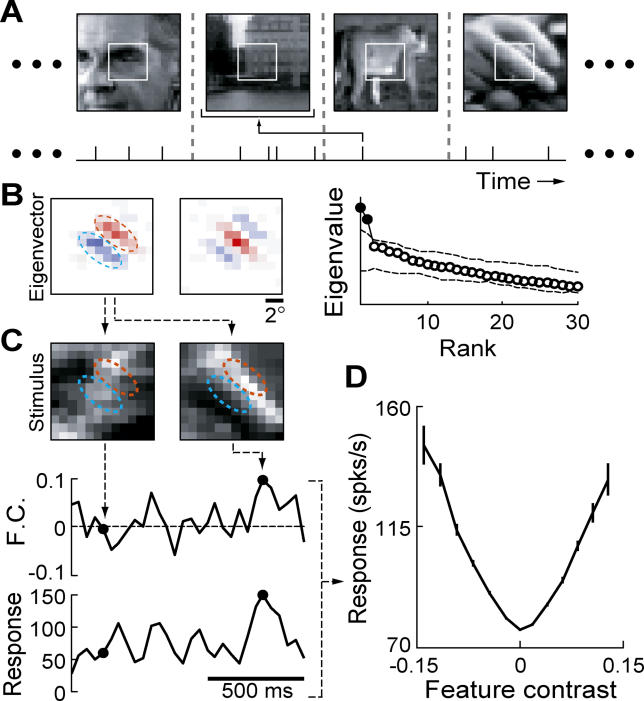
Measurement of Preferred Features and Feature Sensitivity for V1 Complex Cells(A) Upper panel: example natural images. White boxes (12 × 12 pixels) indicate area presented in experiments. Lower panel: schematic spike train, binned at stimulus frame rate (24 Hz, dotted lines). Arrow indicates temporal delay (1 frame) at which preferred features were estimated, which was determined in preliminary studies to be the optimal temporal delay (see Figure S2).(B) Estimation of preferred features (significant eigenvectors) using STC analysis (see Materials and Methods). Left panel: preferred features of a neuron, with light and dark regions represented by red and blue; dashed ovals delineate the first feature to facilitate comparison with the images. Right panel: 30 largest eigenvalues of STC matrix. Dashed lines: control confidence intervals (mean ± 12 standard deviation of control eigenvalues). Filled circles: significant eigenvalues corresponding to eigenvectors shown on left.(C) Upper panel: natural images. Dashed ovals correspond to those in (B). Middle panel: contrast of the first preferred feature (F.C. denotes feature contrast; see Materials and Methods). Lower panel: responses of the neuron (in spikes/s) to natural images. Black dots: feature contrasts (middle) and neuronal responses (lower) for the example images.(D) Contrast-response function. Error bar: ± standard error of the mean.